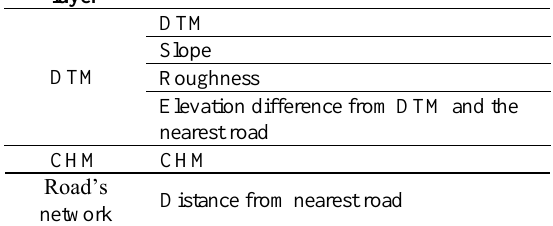
Table 1. Summary of the layers that compose the raster